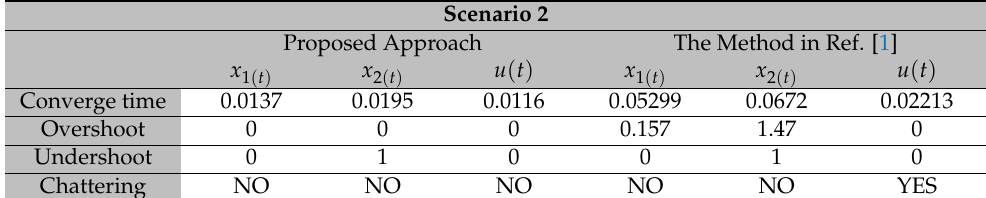
Table 2. Comparing the responses of the DBC system under the conditions of scenario 2. (cid:1) Scenario 2 Scenario Proposed Approach